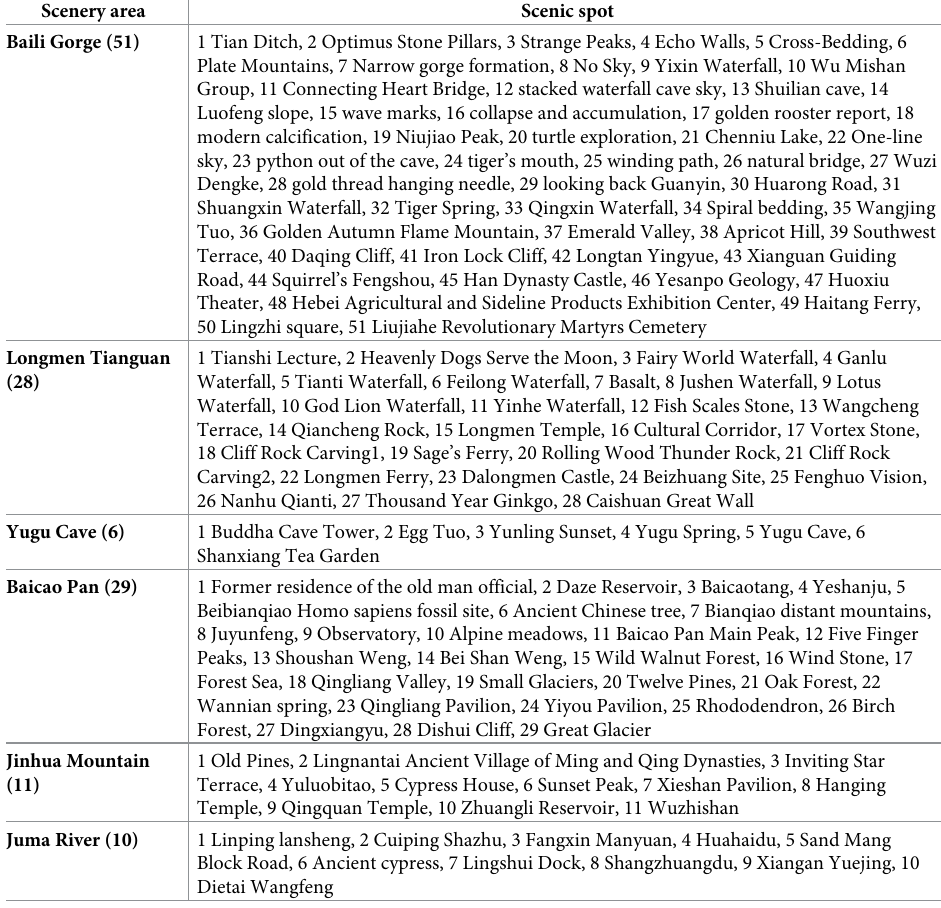
Table 1. List of scenic spots at the Yesanpo National Park. Scenery